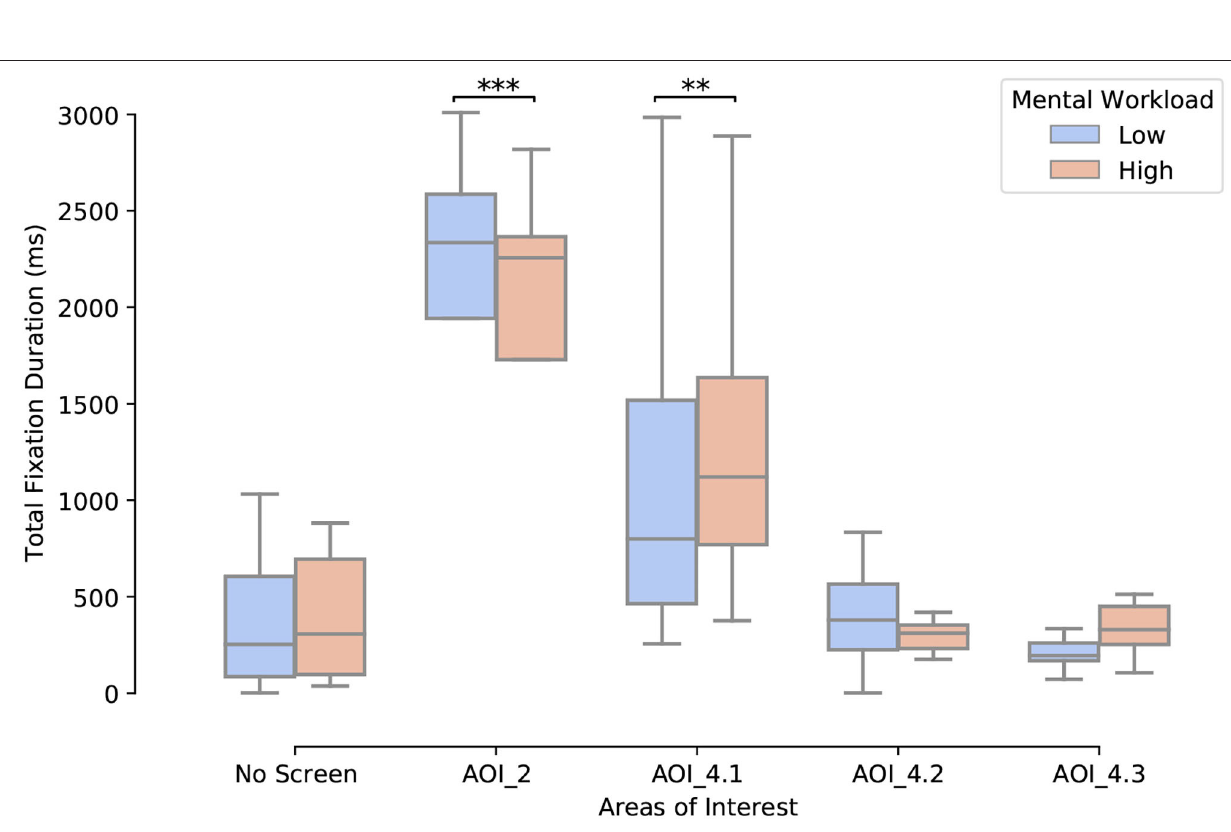
Frontiers in Human Neuroscience |